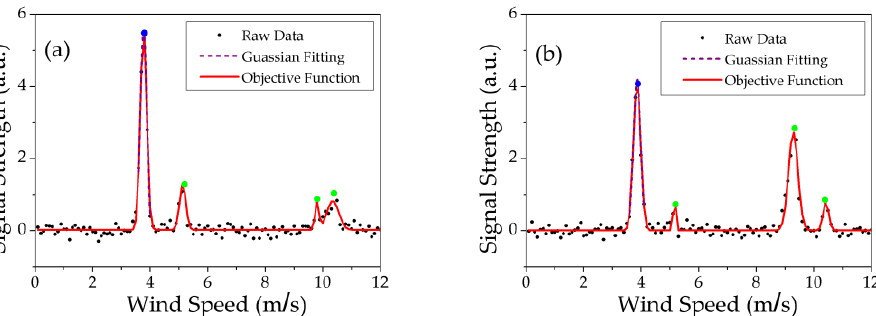
Figure 6. The spectra processed by the HGAP and the GF. ( a ) The processing result of spectrum 1; ( b ) The processing result of spectrum 2. Table 4. The measurement result of Figure